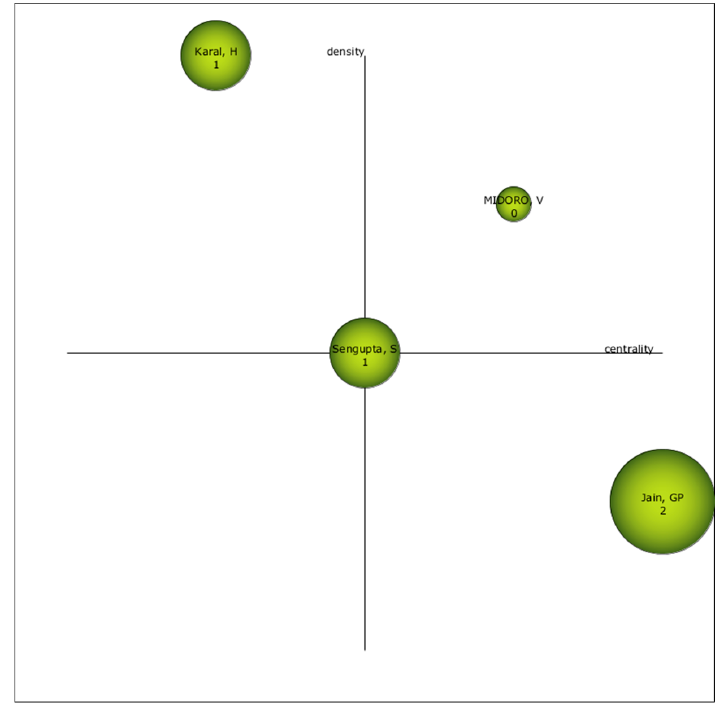
Figure 6. Strategic author diagram of the entire production.